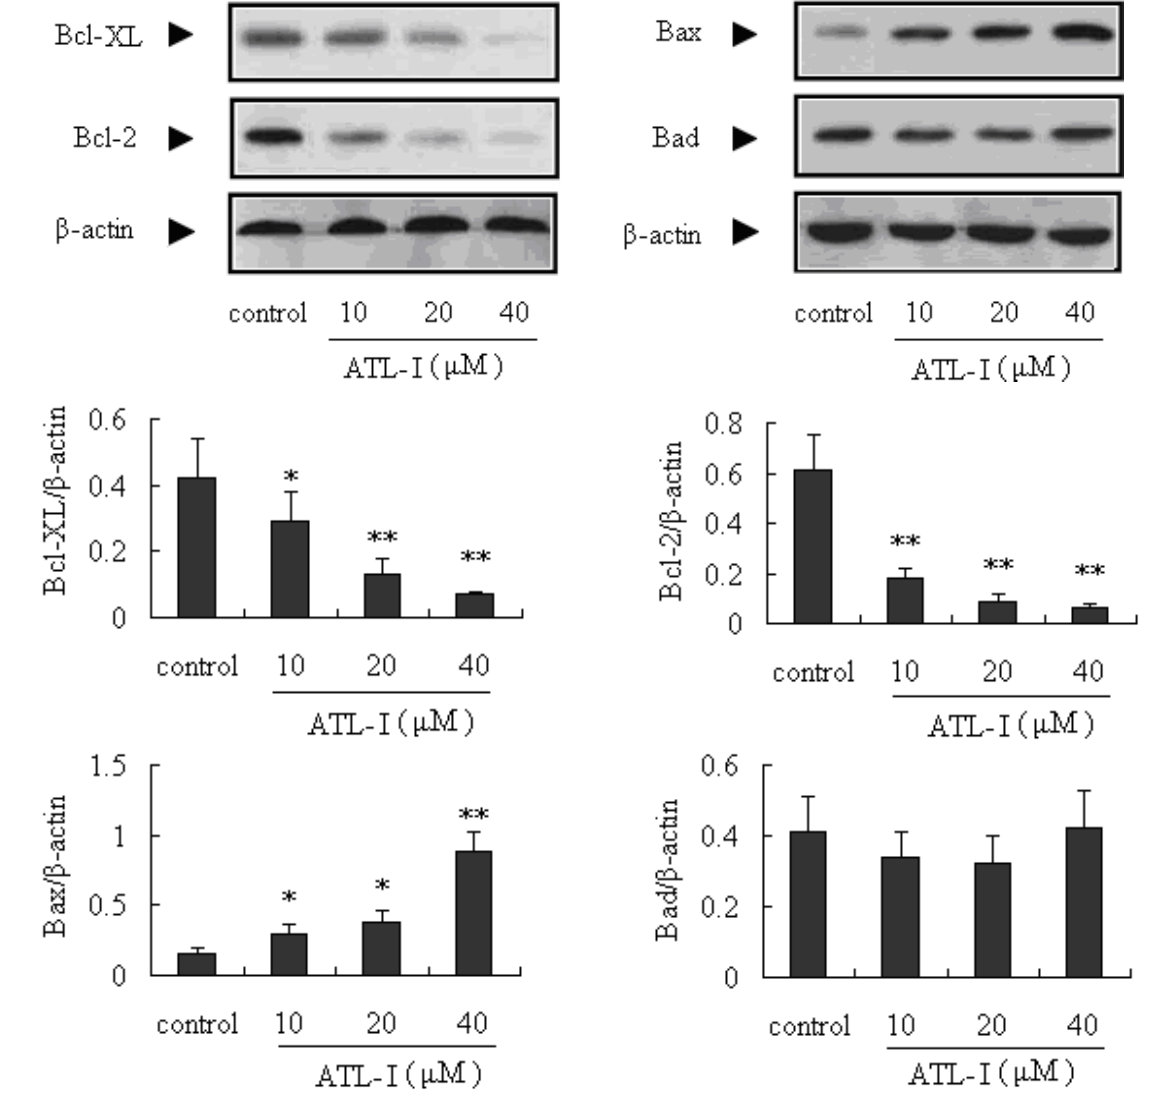
Figure 5. Effect of ATL-I on Bcl-2 family proteins (Bcl-XL, Bcl-2, Bax, and Bad) expressions in A 549 cells. Cells were treated with ATL-1 at the concentrations of 10, 20, and 40 μ M for 48 hours, and the whole cell lysates were determined by western blot analysis using antibodies for Bcl-XL, Bcl-2, Bad, and Bad as indicated. All data